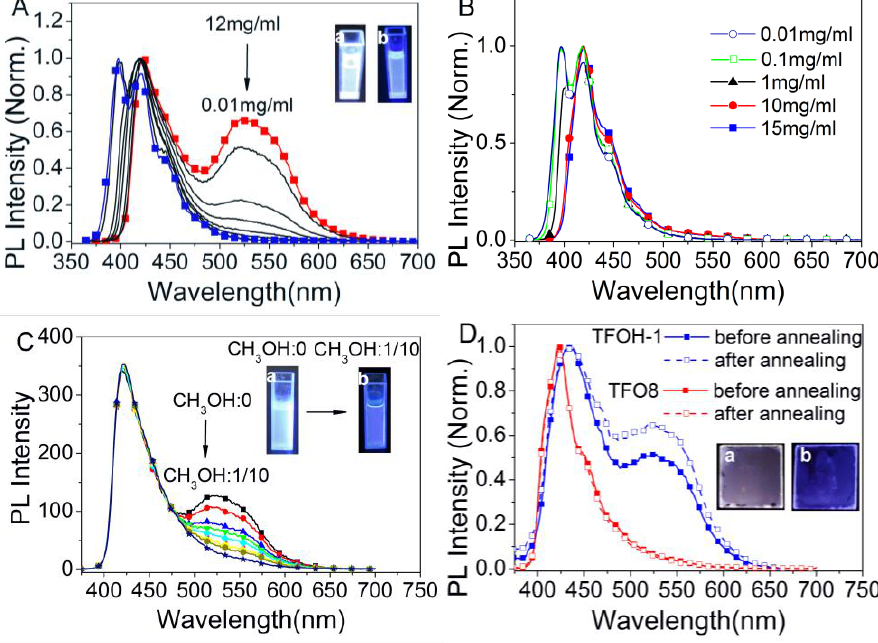
Figure 4. Photoluminescence spectra. ( A ) Concentration dependent PL spectra of